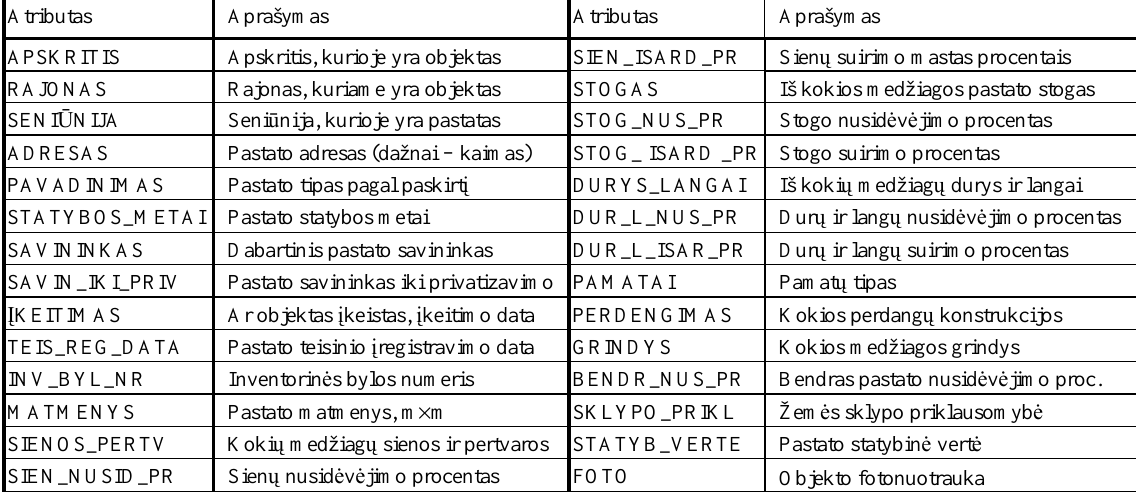
Table 1. Attribute data of derelict rural buildings personal